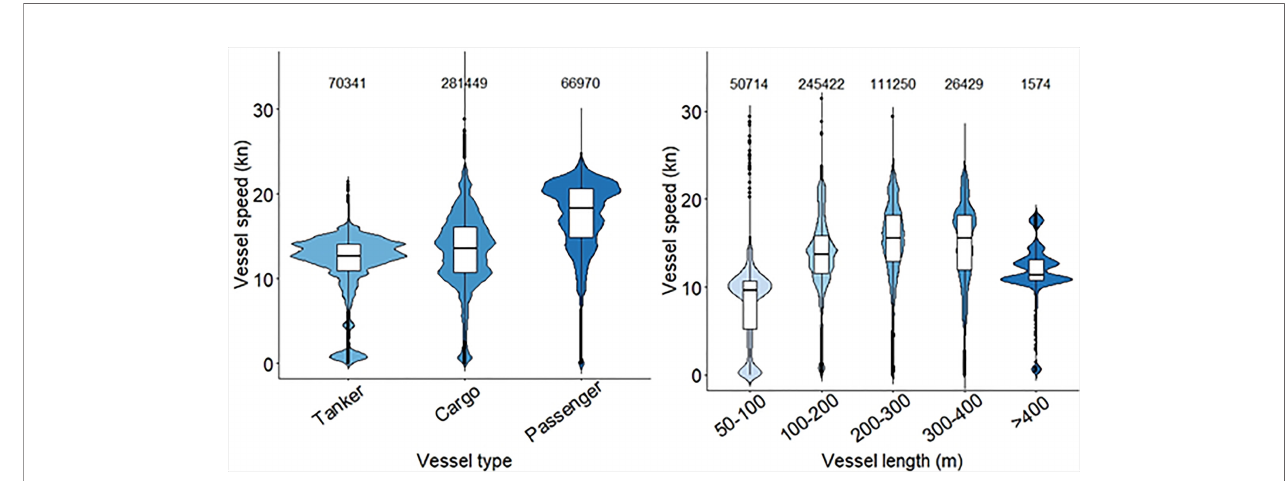
FIGURE 7 | The distribution of vessel speeds in April (from pooled AID data between 2011 and 2020) by vessel type and vessel length in the study area, where fi n whales were observed surface feeding. The number of unique vessels in each category is indicated at the top of each violin